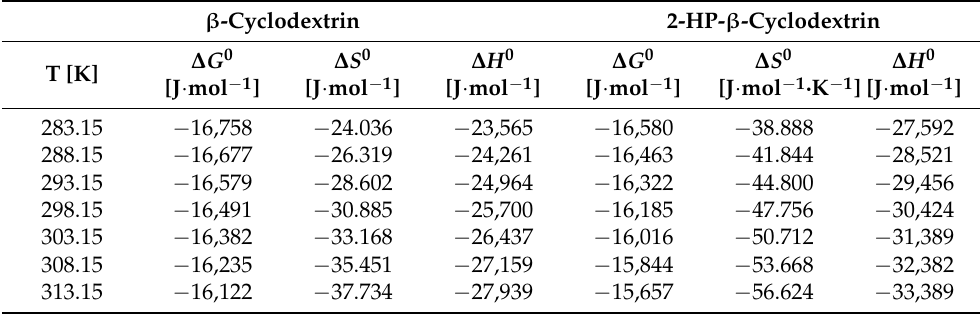
Table 5. The values of thermodynamic functions ∆ G 0 , ∆ S 0 , ∆ H 0 [J · mol − 1 ] for β -cyclodextrin and 2-HP- β -cyclodextrin with the salt of trans -cinnamic